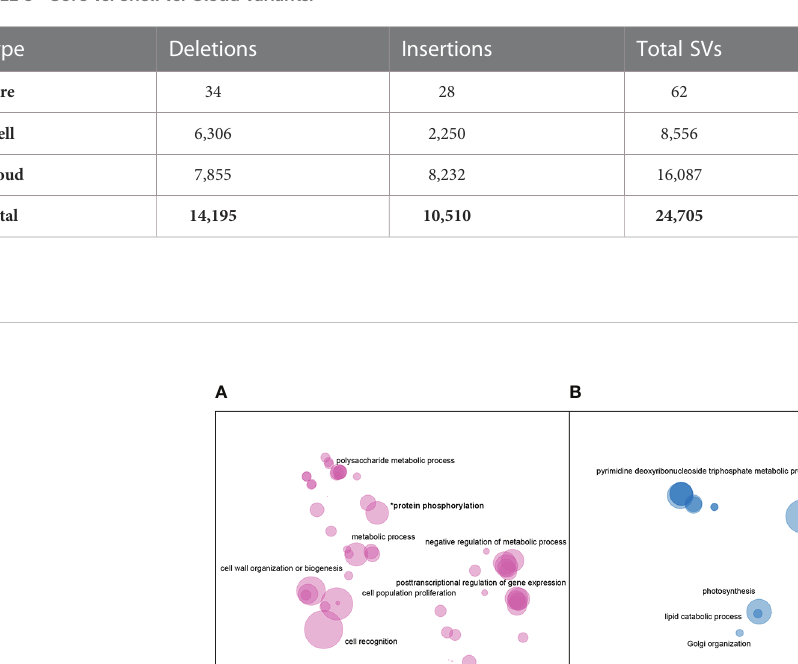
TABLE 3 Core vs. Shell vs. Cloud variants.